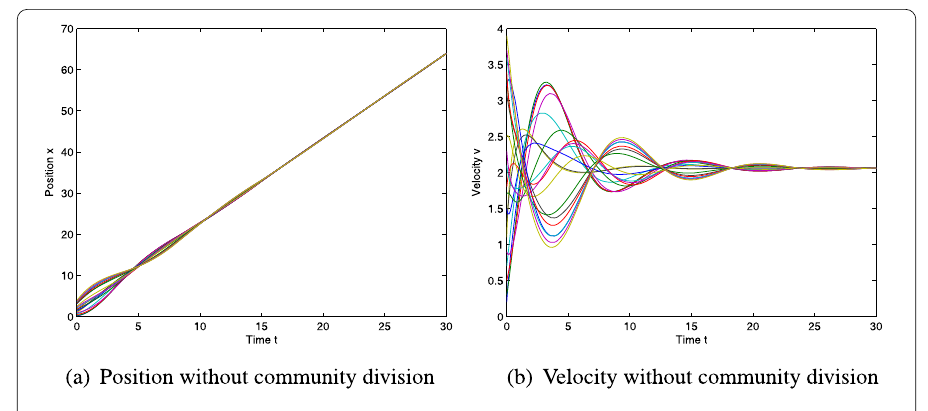
Figure 4 State trajectories of multiagent system